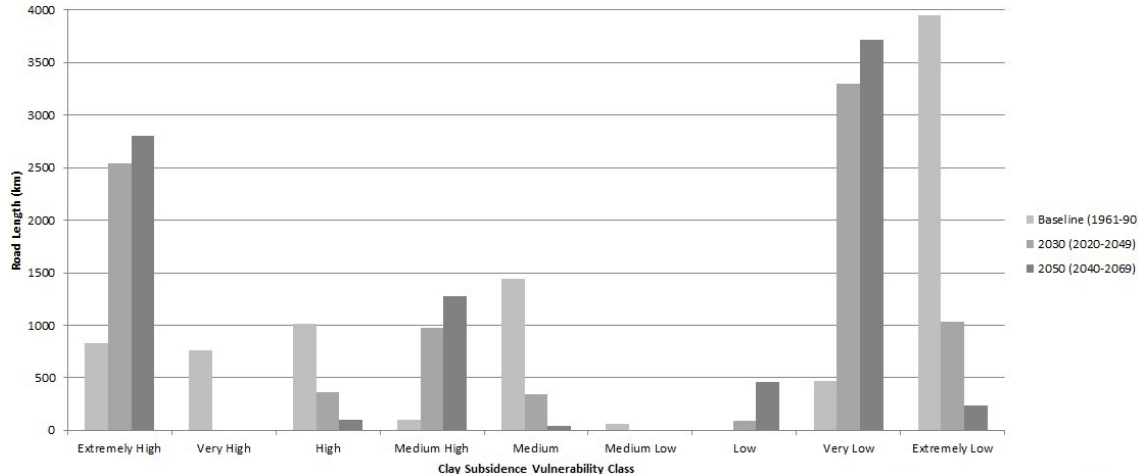
Figure 7. Road length kilometres per clay subsidence vulnerability class for baseline, 2030 and 2050 scenarios.